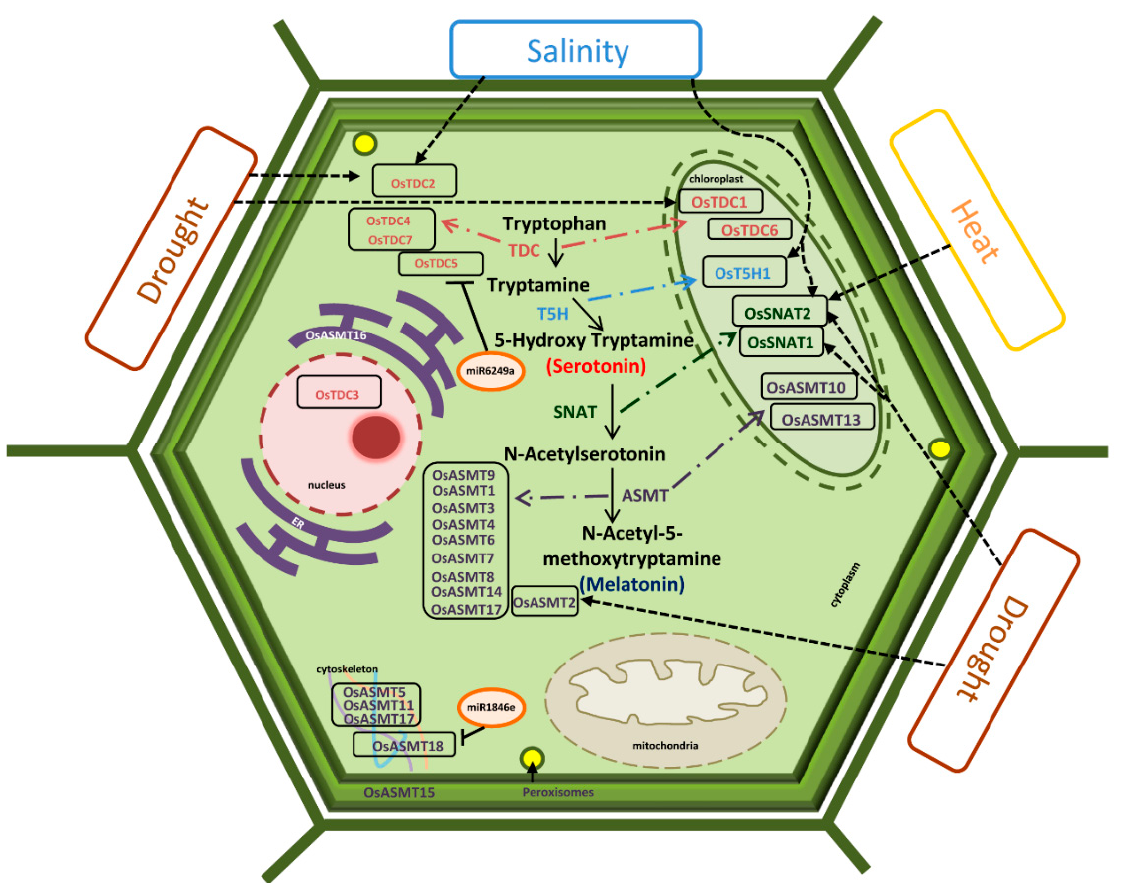
Figure 10. Model summarizing the members of Ser and Mel biosynthetic pathway of rice, highlighting their regulation. The crosstalk between genes encoding enzymes for Ser and Mel biosynthesis (identified by genome-wide analysis) harboured in different sub-cellular compartments, have been illustrated under stress conditions, based on transcript profile validations. The miRNA-based regulation of specific gene family members has also been indicated. The black dotted arrows depict the stress-inducibility of specific transcripts regulating Ser and Mel biosynthesis under various stress conditions, as validated by qRT-PCR. Solid black lines depict regulation of transcripts with specific miRNAs. Coloured arrows depict the genes encoding the enzymes involved in the Ser and Mel biosynthesis.